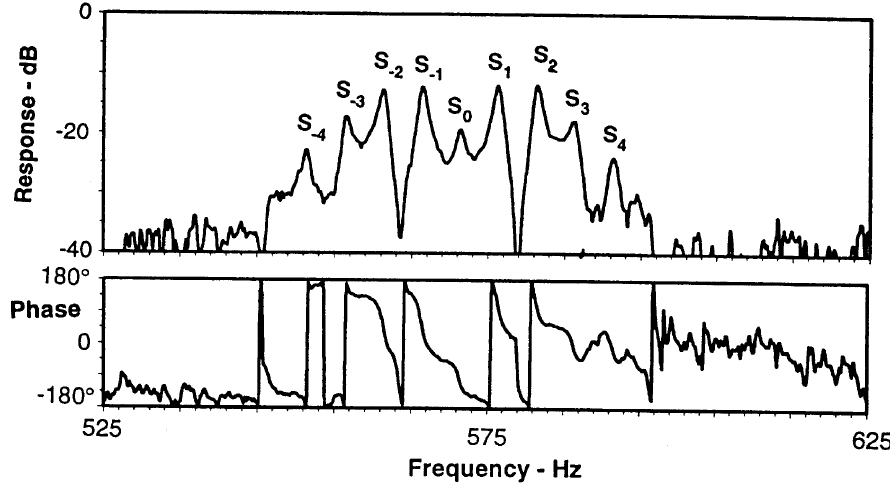
Fig. 5. CSLDV response spectrum, corresponding to Fig. 2.